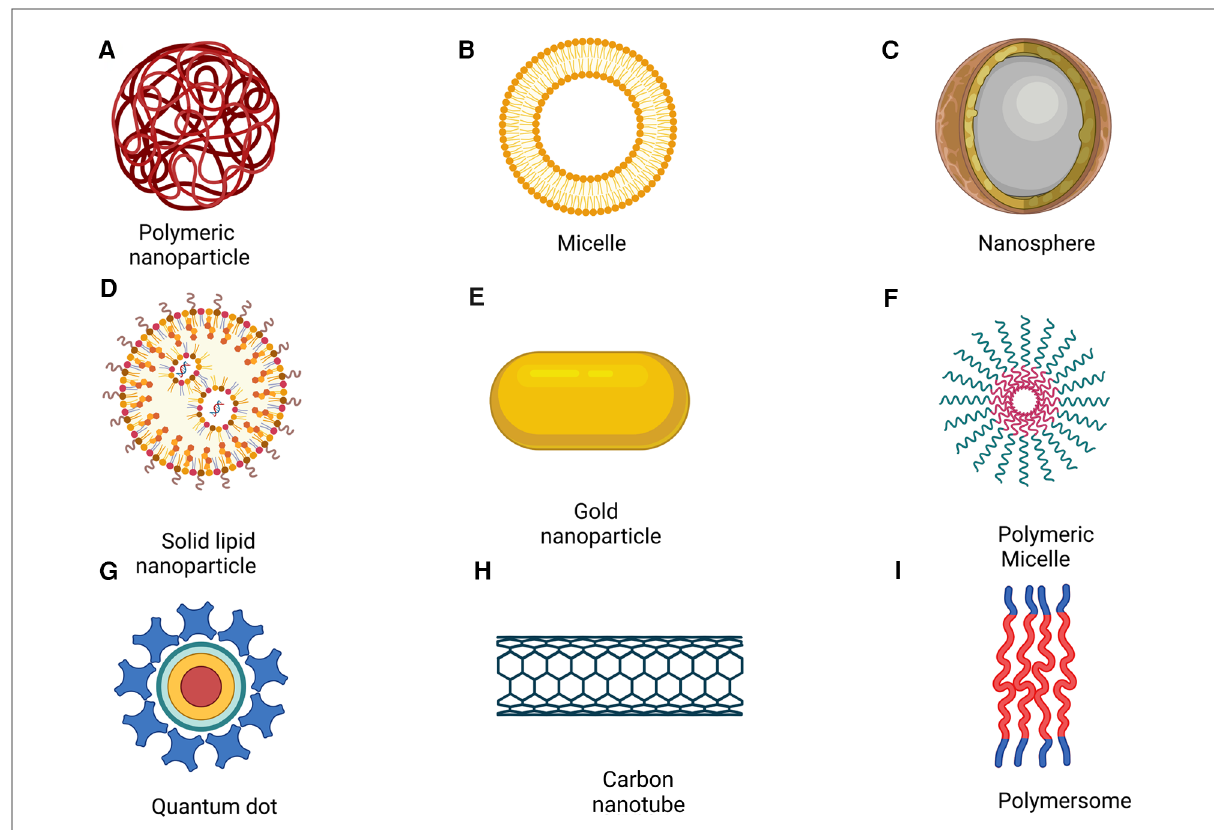
FIGURE 1 Nanoparticles for drug delivery. (Reprinted from “ Nanoparticle-Mediated Targeted Drug Delivery to Cancer Stem Cells ” , by BioRender, June